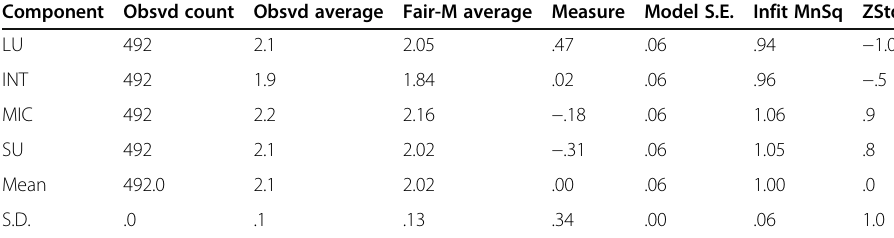
Table 2 Components measurement